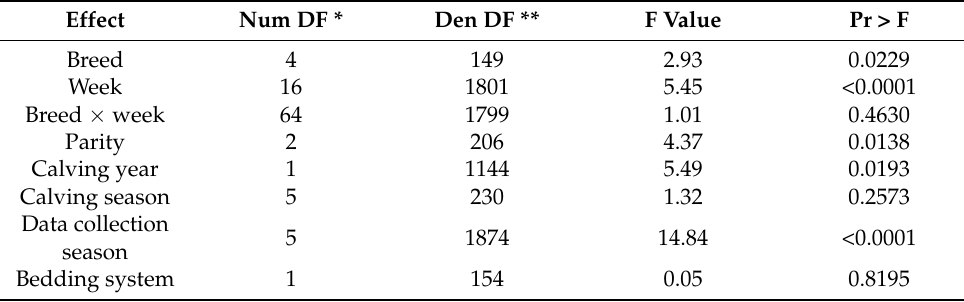
Table A3. Variance analysis results for the variable beta-hydroxybutyrate (BHBA).